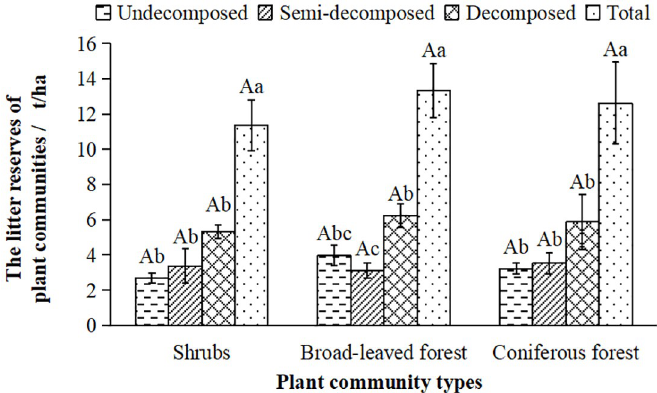
Fig 2. The litter reserves ( M ) in the typical plant communities. Note: Lowercase letters indicate within-group differences and uppercase letters indicate between-group differences (ANOVA followed by LSD, P < 0.05). The same is